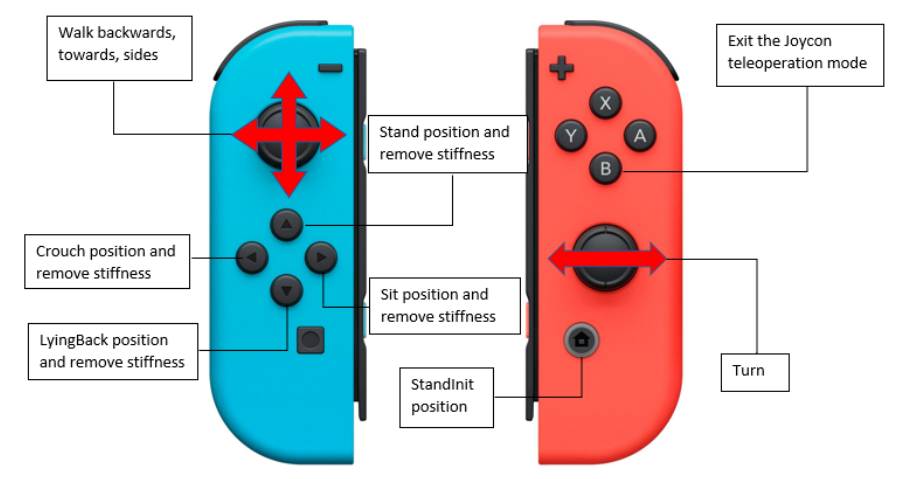
Figure 6. Button disposition of the